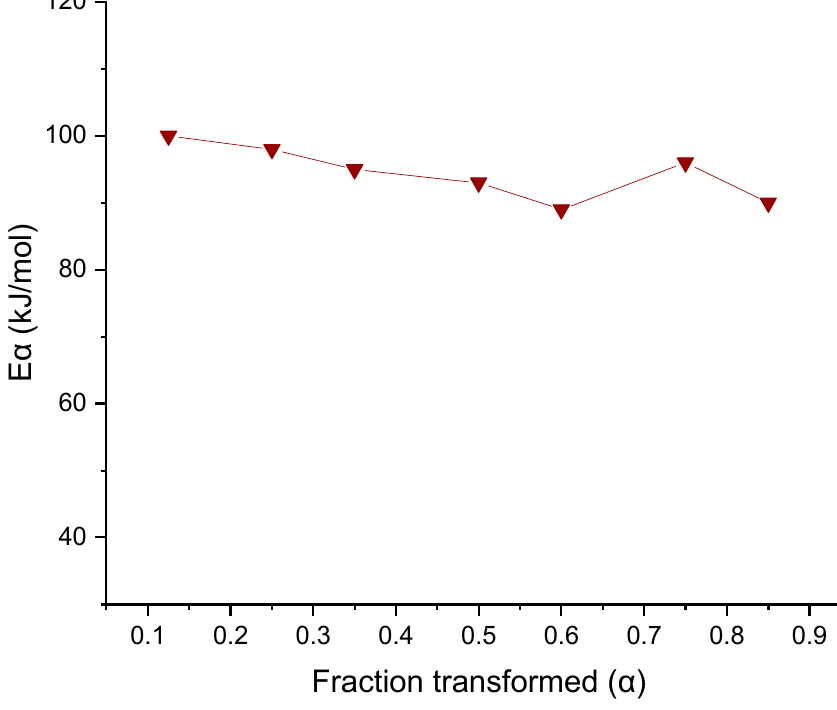
Figure 15. Activation energy ( E α ) plots against the converted mass fraction ( a ) during dehydration, as calculated by Vyazhovkin’s isoconversional method.